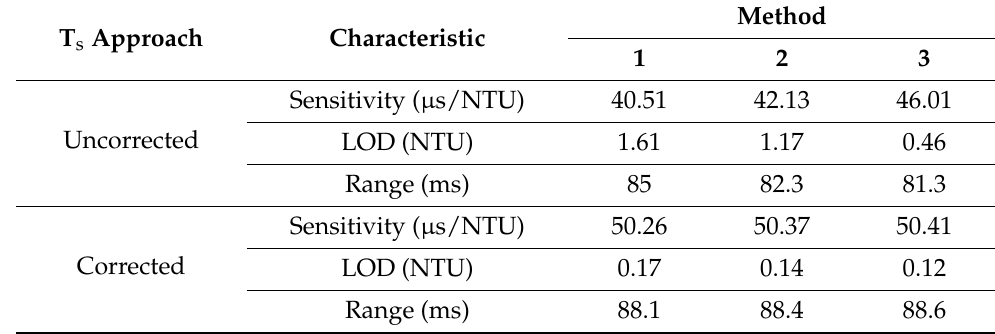
Table 4. List of calculated sensory characteristics: sensitivities, limits of detection (LOD) and range for each method and